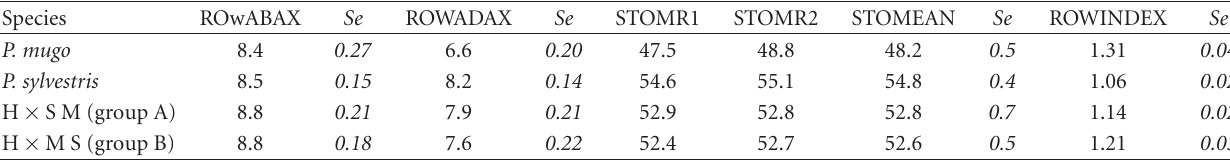
ROWABAX and ROWADAX-number of stomata rows on abaxial (curvy) and adaxial (flat) needle surface; STOMR1 and STOMR2: number of stomata per 5mm interval in row 1 and row 2; STOMEAN: mean of STOMR1 and STOMR2; ROWINDEX: stomata row index =